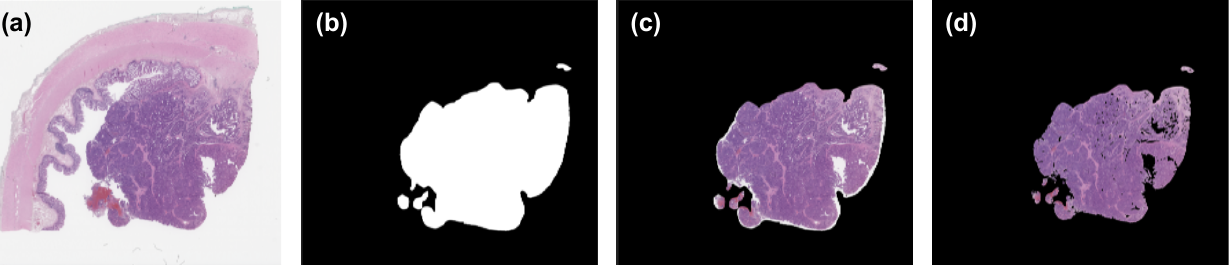
Figure 2. The original whole slide image (WSI) and the associated tumor mask: ( a )the original WSI, ( b )the tumor mask created from the given XML annotation, ( c )the segmented tumor area from WSI, and ( d )the created tumor mask without